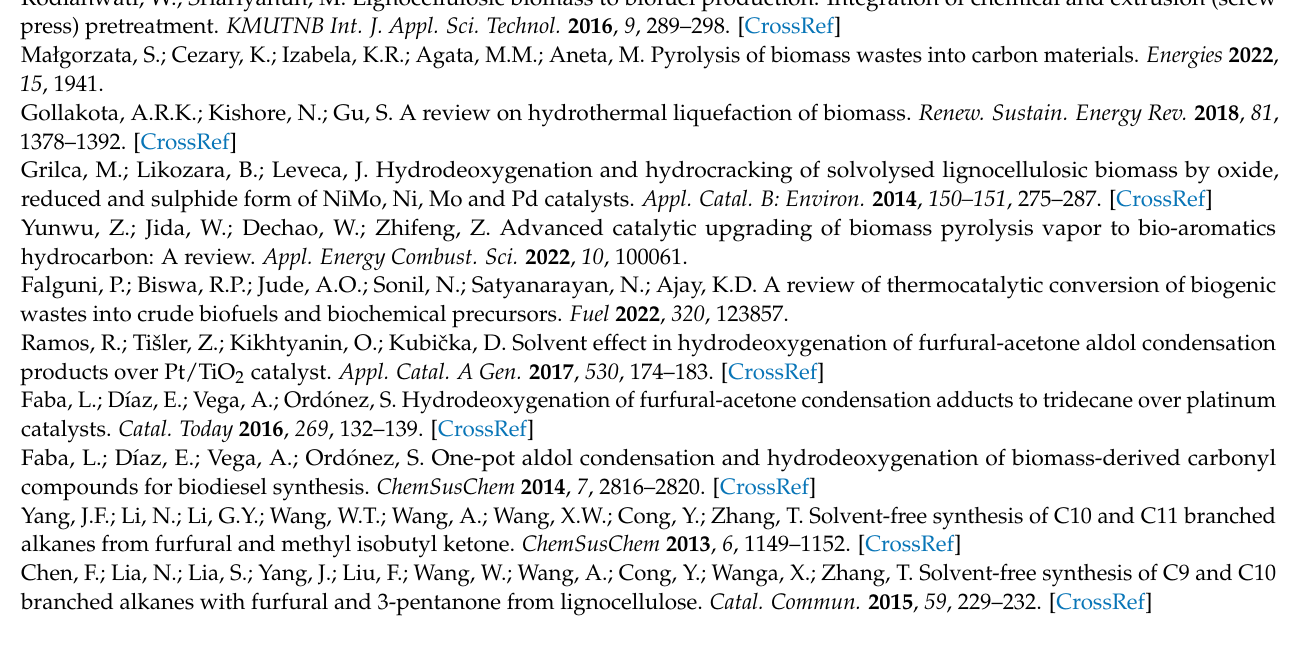
Figure S3: Possible molecular configuration of acetone and 2-butanone adsorbed on a representative MgAl mixed oxide as deduced from in situ FTIR study; Table S1: Crystallite size and Mg/Al molar ratio of prepared MgAl LDH series; Table S2: The result from GC-MS analysis and notation of unsaturated carbonyl compound as the obtained product of aldol condensation of furfural and 2-butanone; Table S3: Assignment of FTIR bands observed in acetone and 2-butanone adsorption on a representative MgAl mixed oxide; Table S4: The fitting parameters of CO 2 - and NH 3 -TPD profile of LDO2, LDO3, and LDO4; Table S5: Input: Optimization of the adsorption of 2-butanone on MgO(100) (methylene enolate route); Table S6: Input: Optimization of the adsorption of 2-butanone on MgO(100) (methyl enolate